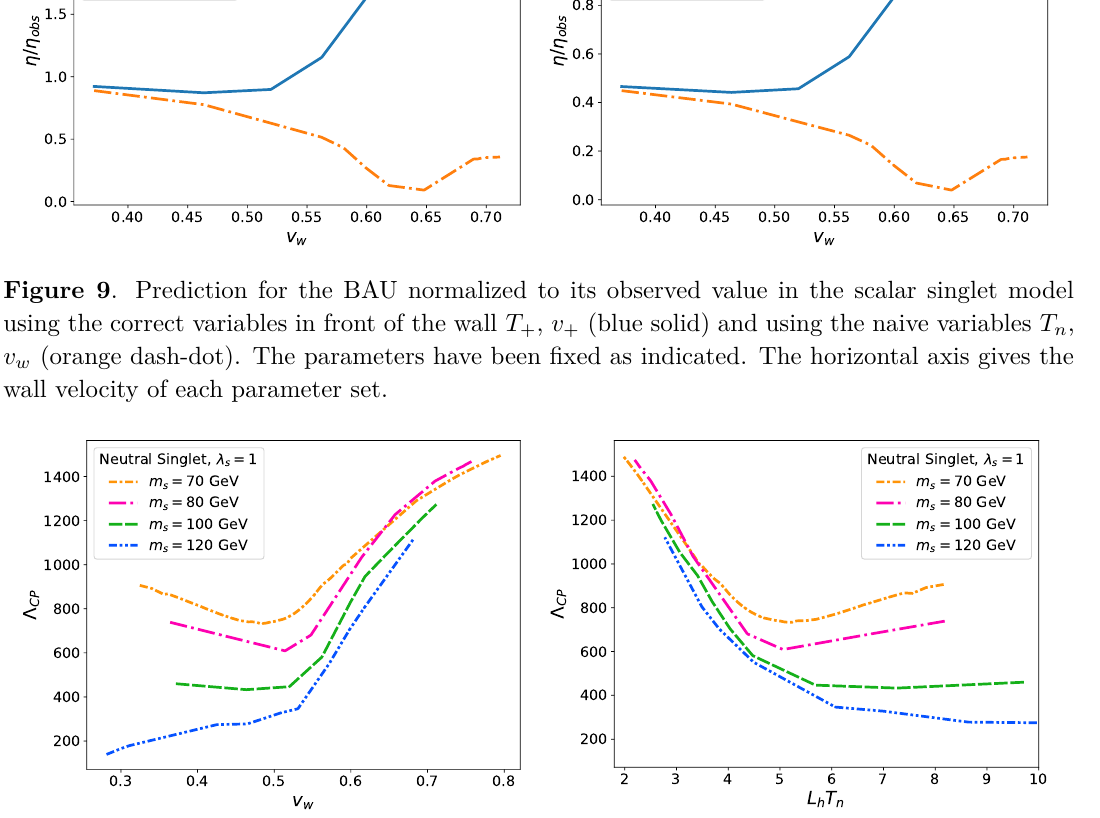
Figure 10 . Cut-off scale Λ CP required to obtain the observed baryon asymmetry as a function of the wall velocity (left panel) and wall thickness (right panel) in three benchmark values of the mass m s = 70 , 80 , 100 , 120 GeV in the scalar singlet